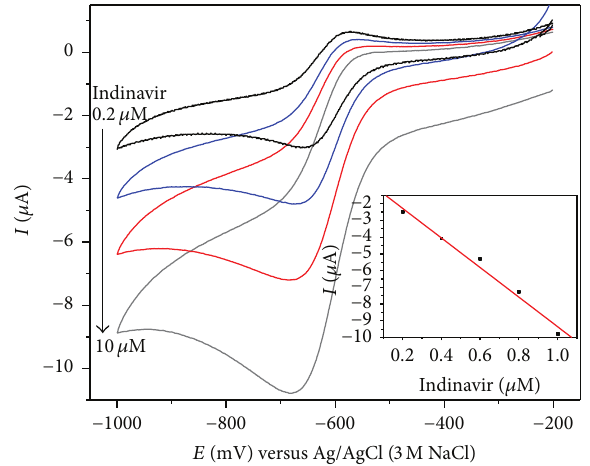
Figure 7: CYP3A4-based biosensor in the presence of increasing Indinavirconcentrations(0.2to10 𝜇 M).Inset:cathodicpeakcurrent versus Indinavir